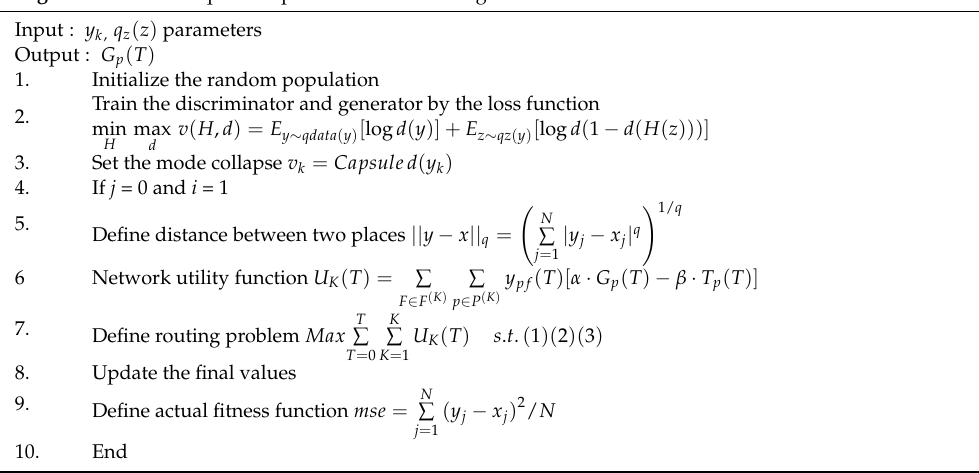
Algorithm 3. Pull-Request Duplicate Detection Using